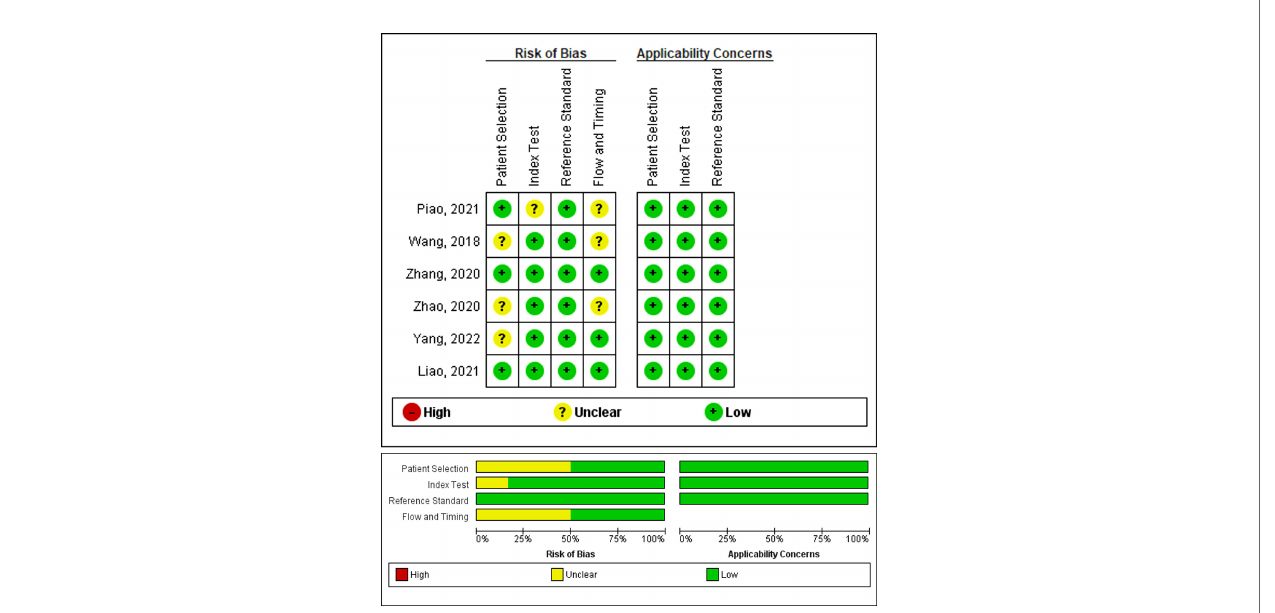
FIGURE 2 | Assessment of the methodological quality of publications included in the meta-analysis, based on the bias risk and applicability using the QUADAS-2 tool. Green, yellow, and red circles denote low, unclear, and high bias risks,